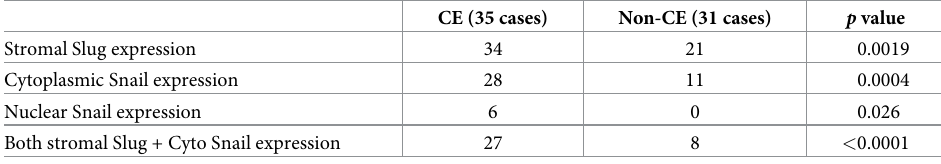
Table 3. The associations between chronic endometritis and the expression of EMT markers in specimens.